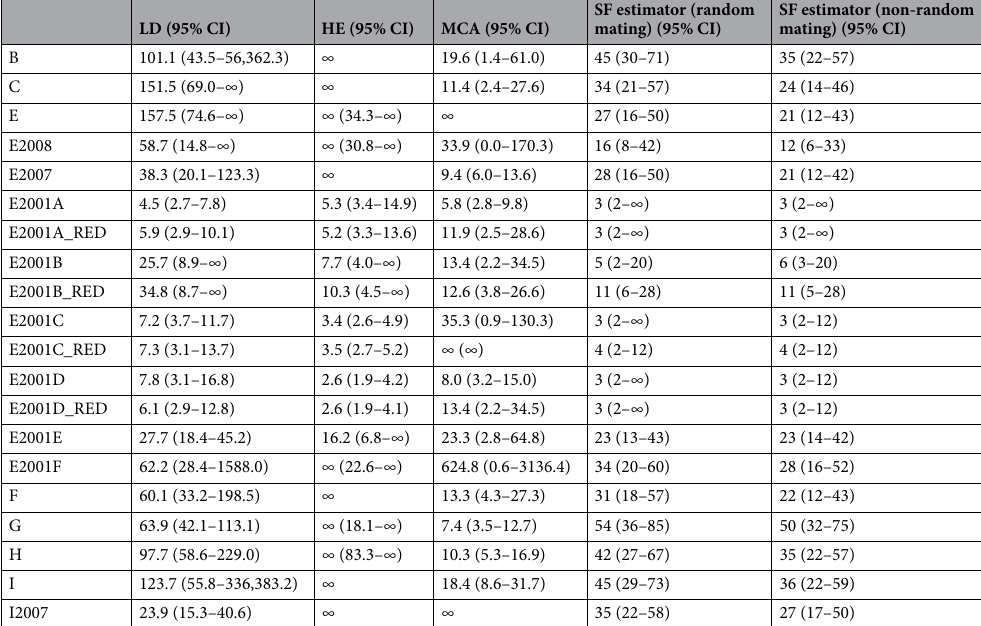
Table 4. Effective population-size estimates for all zones and temporal groups identified. We used four different estimators: linkage disequilibrium method (LD 38,39 ), heterozygote excess method (HE 40 , molecular coancestry method (MCA 41 ), and the sibship frequency estimator (SF 43 ). For all estimators, the point